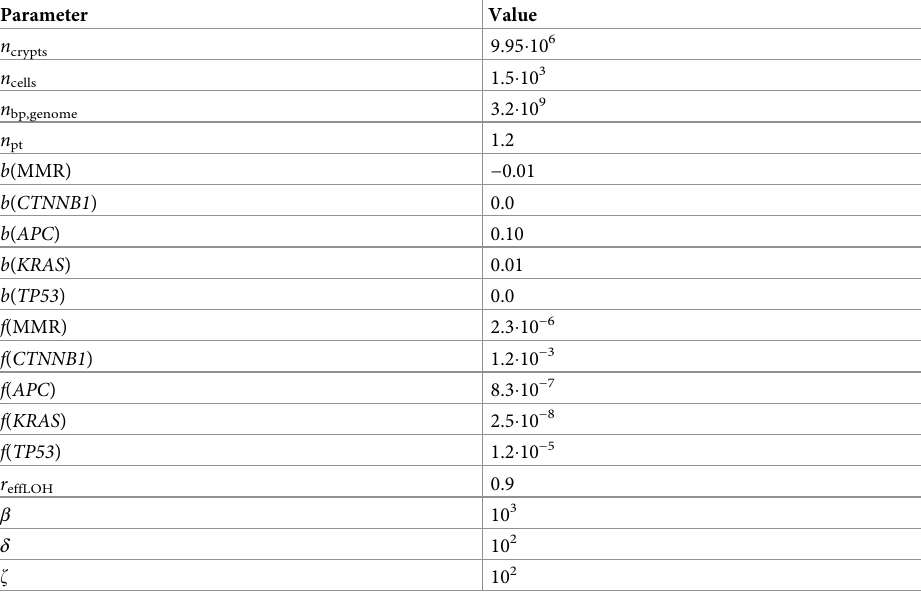
Table 3. Parameter setting for the shown results.